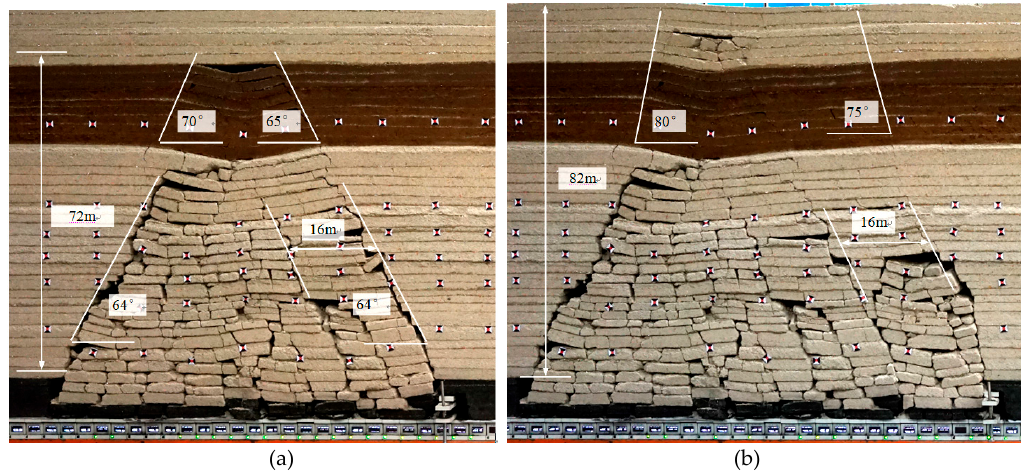
Figure 24. The main roof caving moment: (a) advanced to 82m; (b) advanced to 98m.